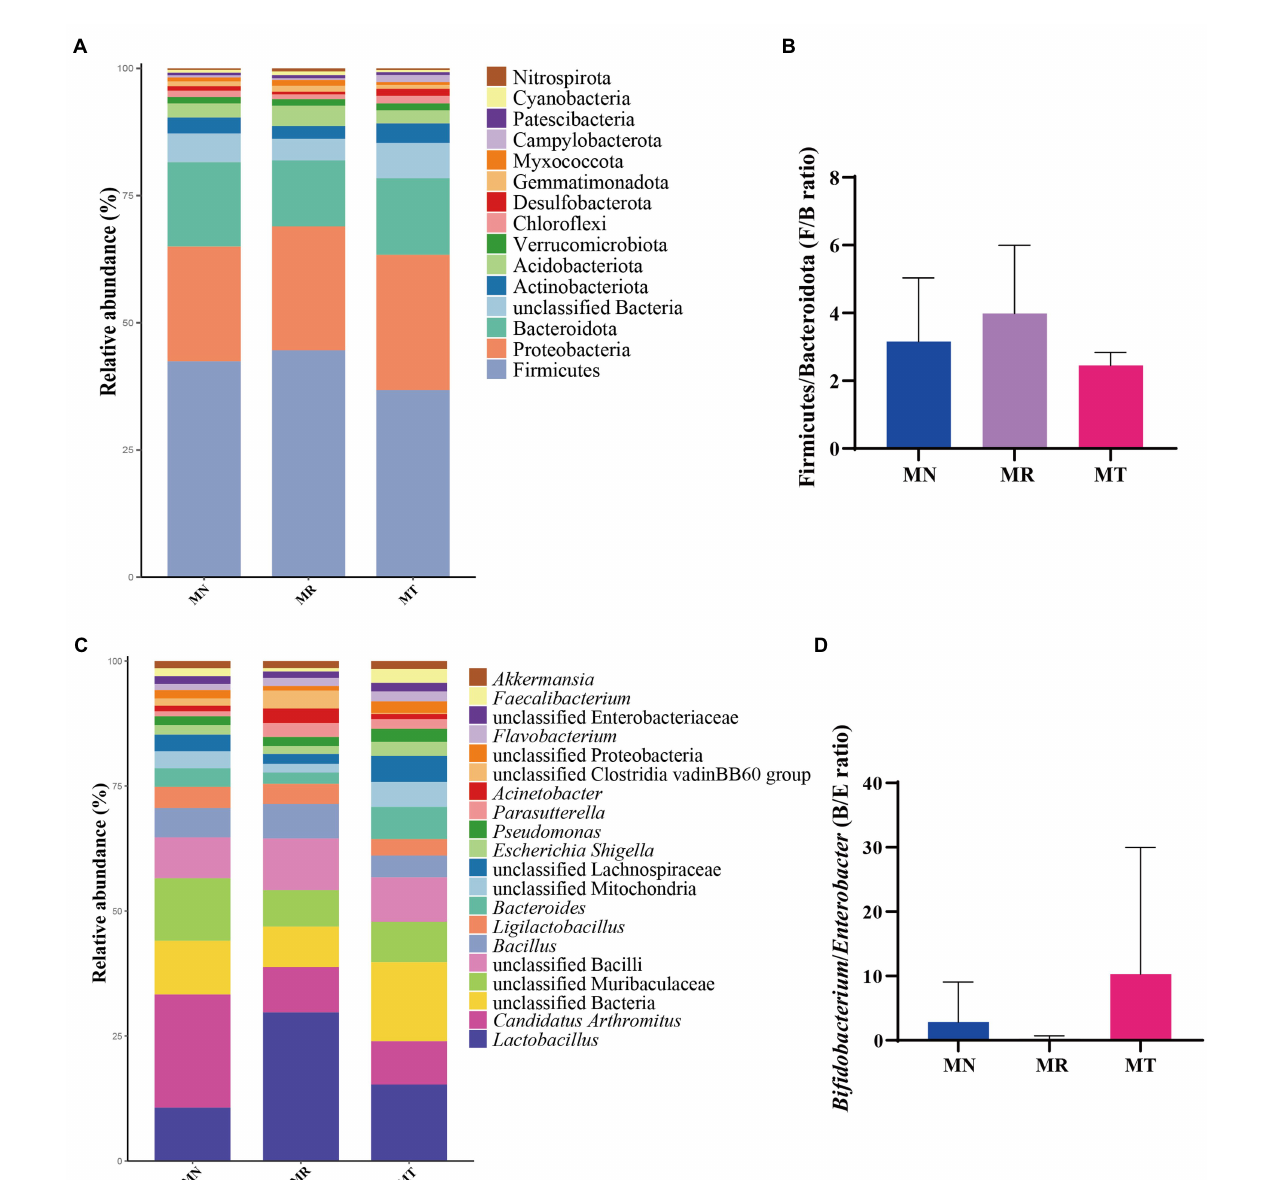
FIGURE 7 Effect of SMD on the relative abundance of bacteria in the intestinal mucosa of mice with spleen deficiency constipation. (A) Relative abundance at the phylum level. (B) Histogram of the Firmicutes/Bacteroidota (F/B) ratio. (C) Relative abundance at the genus level. (D) Histogram of the Bifidobacterium/ Enterobacter (B/E) ratio